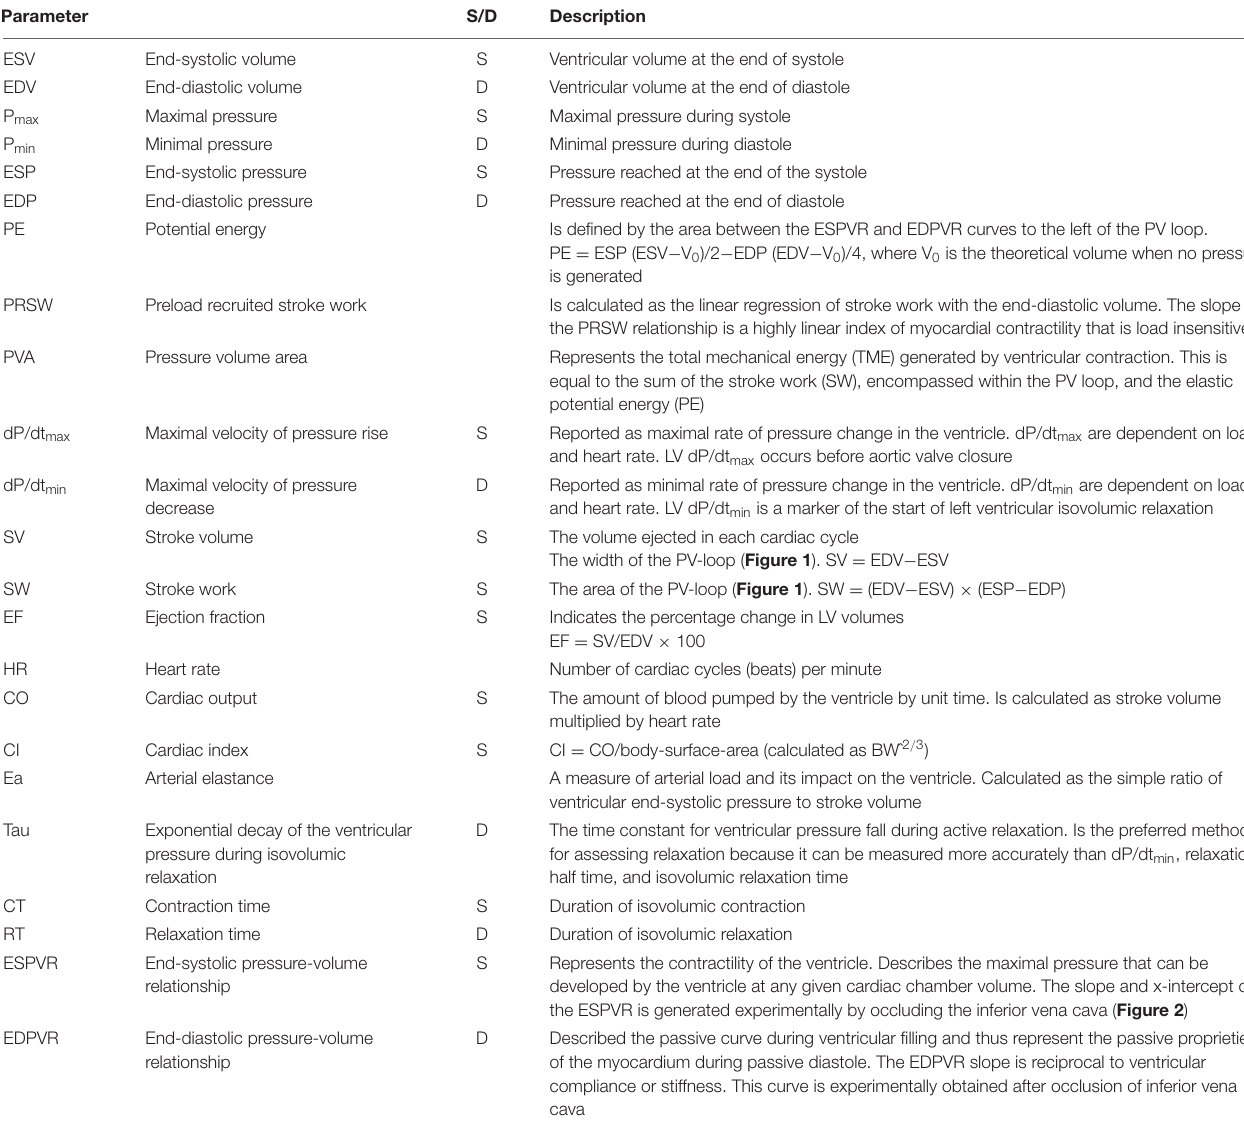
TABLE 1 | PV loop derived